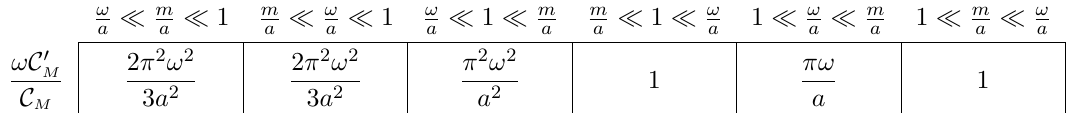
Table 5 . Leading-order behaviour for the function ! C 0 of parameter space. Notice it is only possible to satisfy ! C 0 the (cid:12)rst three columns.)